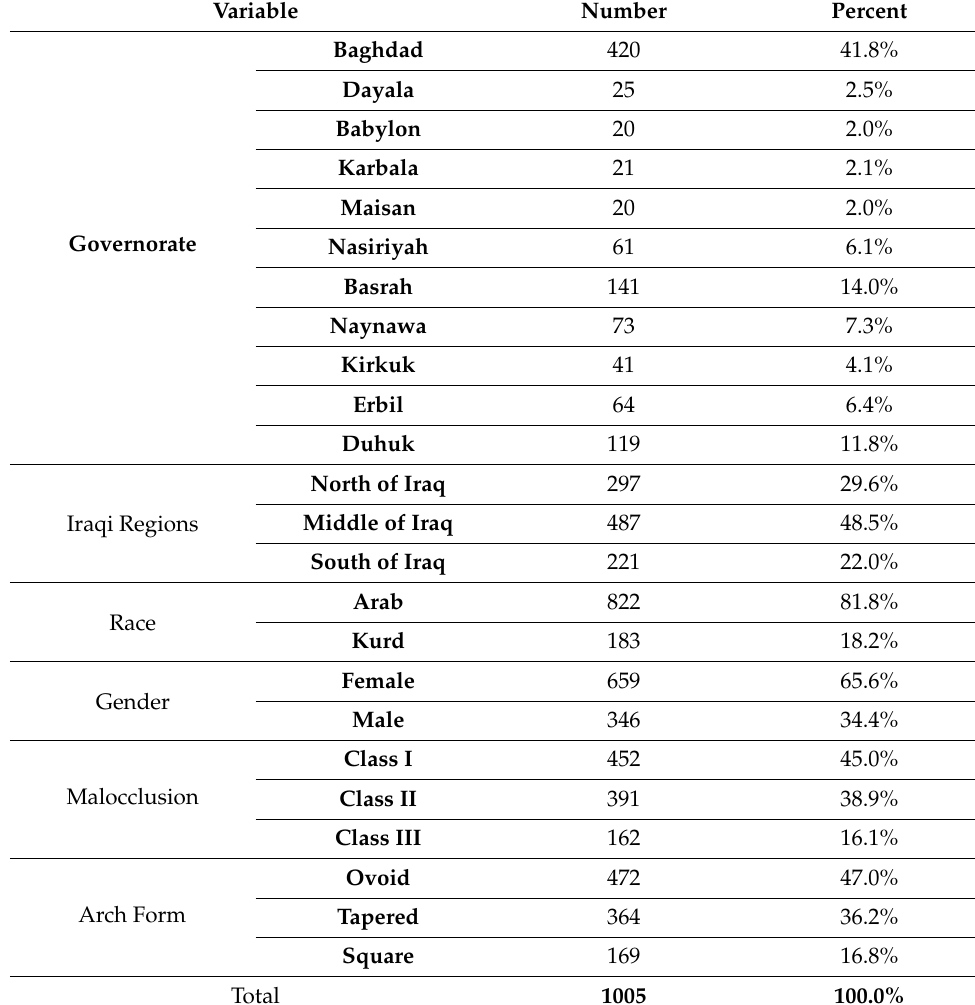
Table 1. Frequency and percentages of sample distribution.